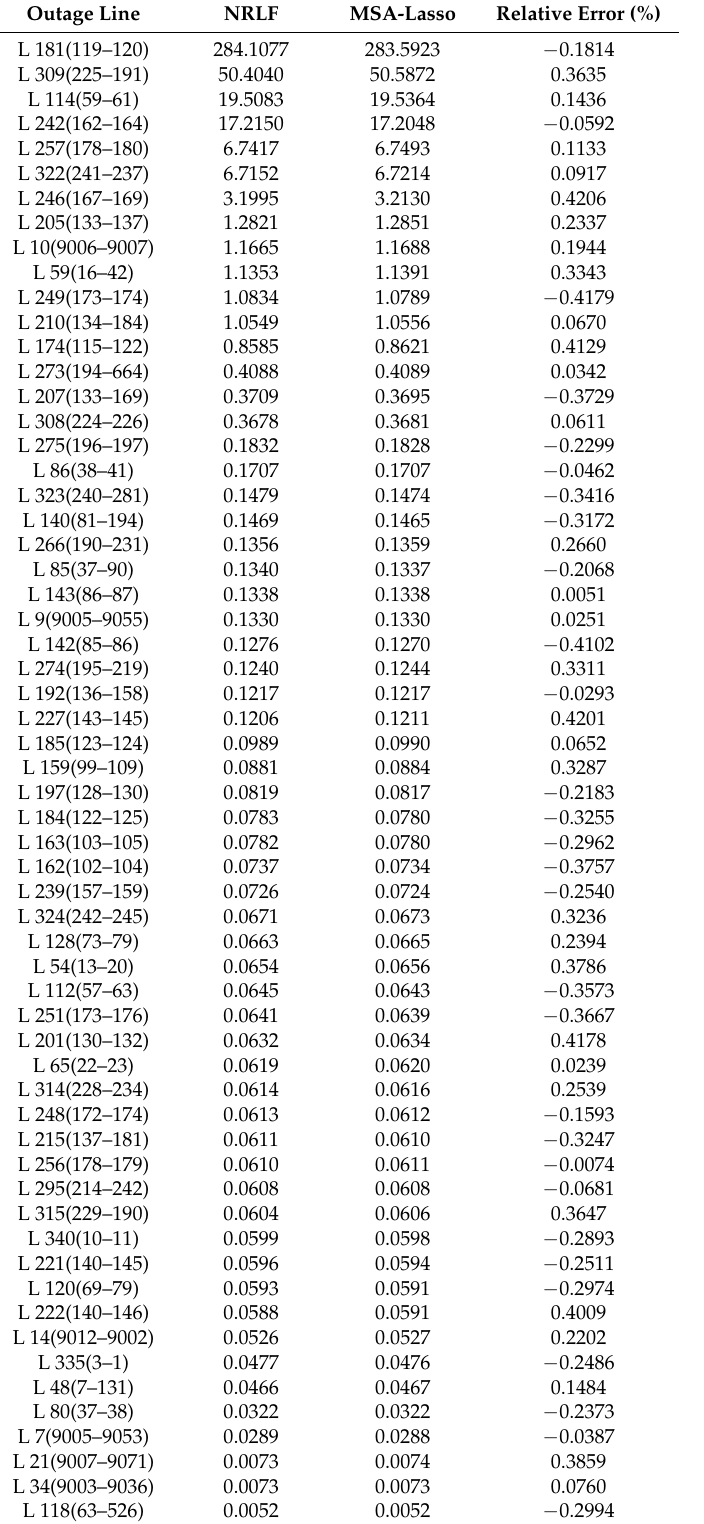
Table 15. Security index results of two methods in the base load condition of the IEEE 300-bus